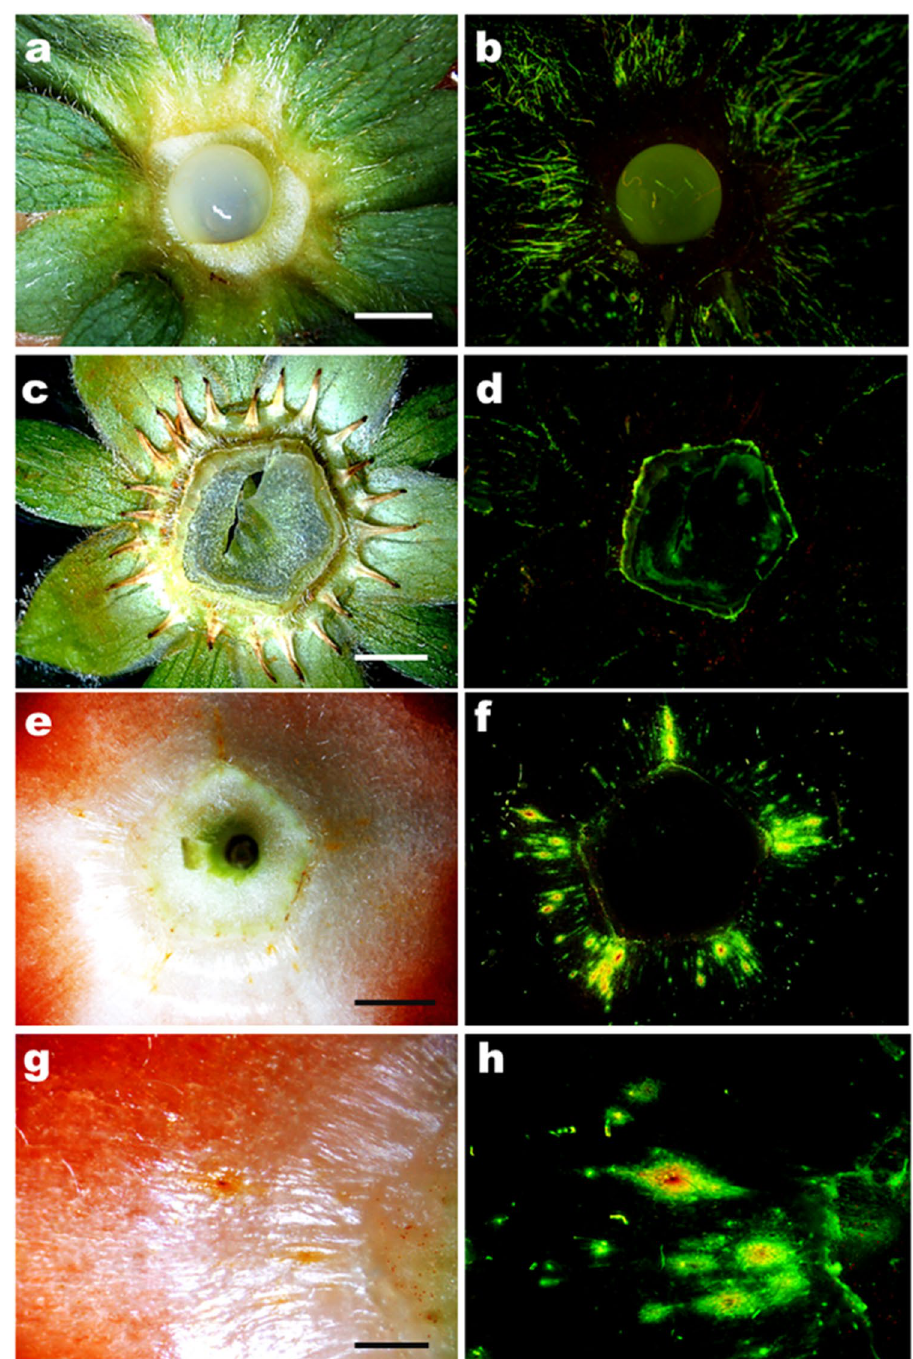
Figure 5. Micrographs of the calyx region of ripe strawberries cv. Sonsation after incubation in the fluorescent tracer acridine orange. Images were taken in incident bright light ( a, c, e, g ) and incident fluorescent light ( b, d, f, h ). a, b abaxial surface of sepals and episepals with numerous trichomes stained by acridine orange. The opaque dot in the center is a drop of silicone rubber that was applied for sealing the peduncle end; c, d adaxial surface of sepals and episepals; e, f top view of the seedless zone of the receptacle below the calyx showing fluorescing microcracks in the vertices of the pentagon-shaped base; g, h same as e, f but microcracks at higher magnification. Scale bar in a,c,e = 3 mm, and g = 1